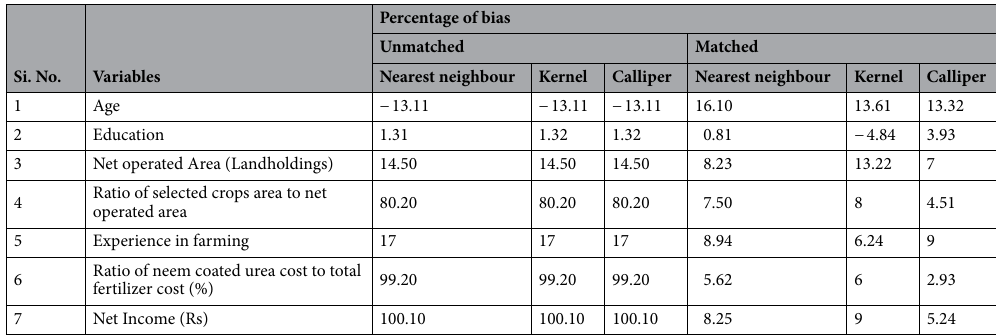
Table 11. Propensity score matching by balancing test of individual covariates. Source: Authors’ estimates using field survey data.